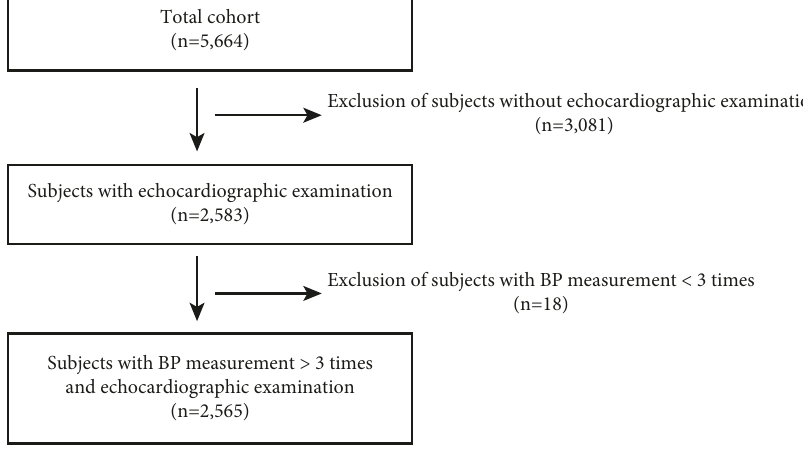
Figure 1: Study population flow